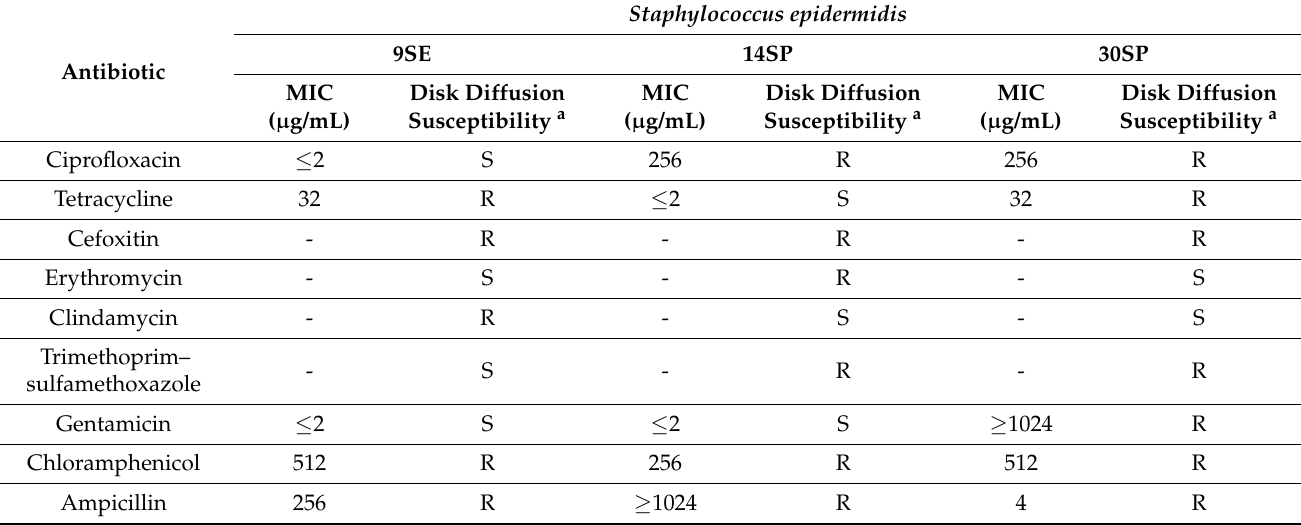
Table 1. Antimicrobial susceptibility testing of selected antimicrobial agents used against bacterial